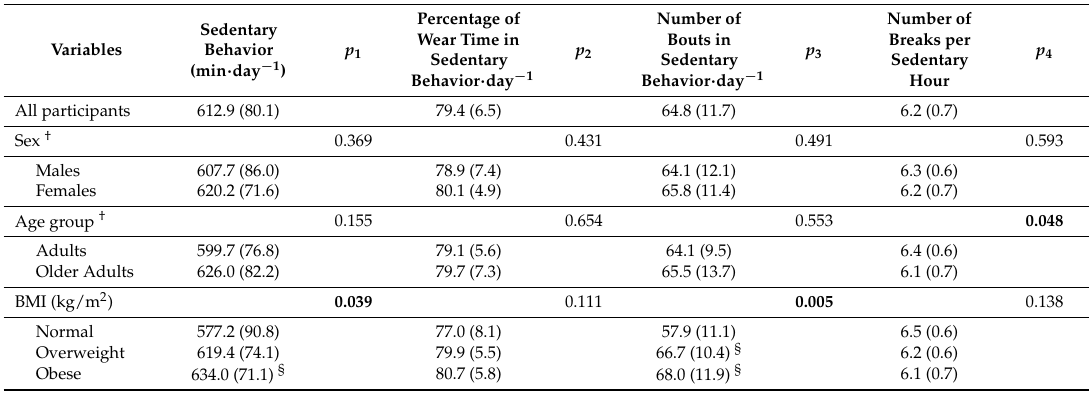
Table 4. Time in sedentary, percentage of sedentary behavior · day − 1 , number of sedentary bouts · day − 1 , and number of breaks per sedentary hour.